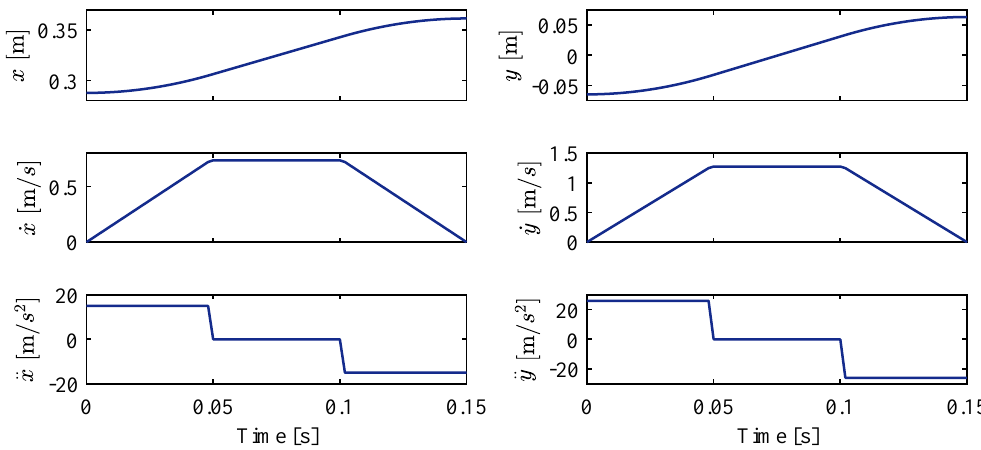
Figure 6. Example trajectory ( φ = 0.00 rad , d = 0.325 m , θ = π /3 rad , and z = − 1.00 m fixed): position, velocity, and acceleration of the x and y end-effector coordinates ( ϑ are not taken into account).